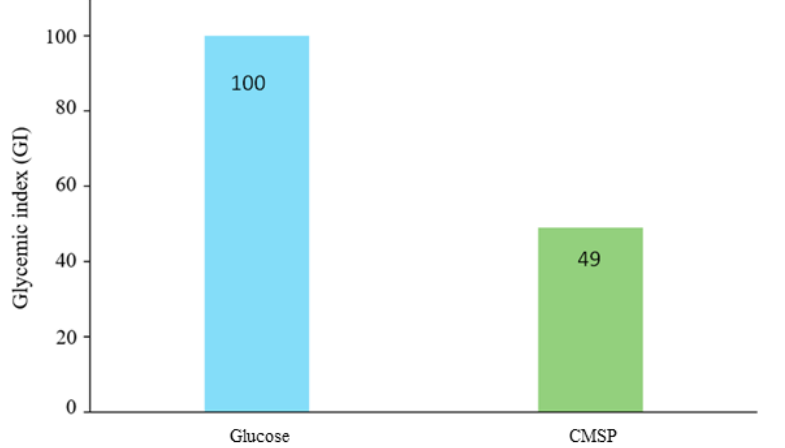
Figure 6. Glycemic index of the CMSP and glucose in Wistar rats. It is calculated from the blood glucose levels in Wistar rats after administration by oral gavage of glucose solution and sulfated polysaccharides of C. muelleri at 25 mg/mL.